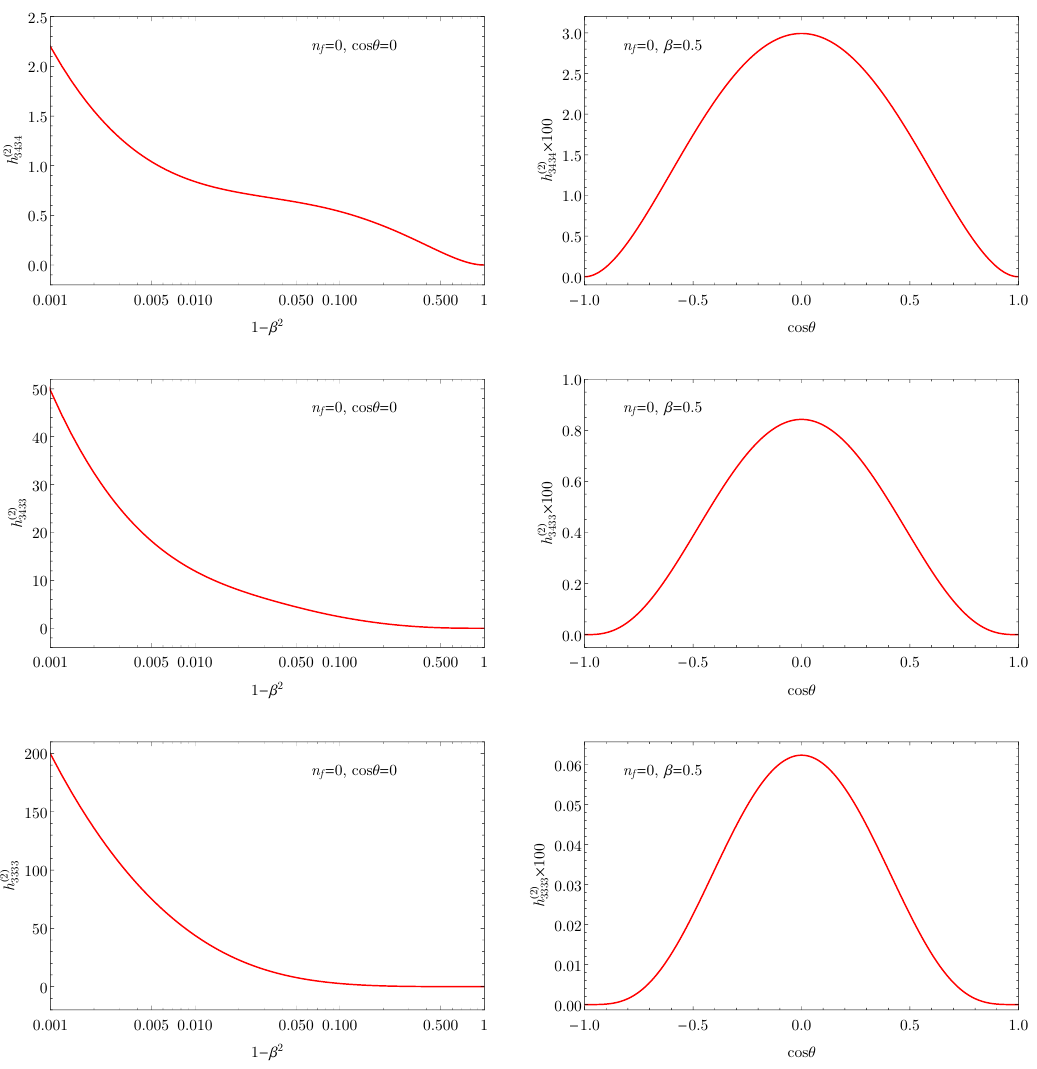
Figure 3 . Same as in figure 2 for the contributions proportional to T 3 · T 4 T 3 · T 4 (upper panels), (lower C F T 3 · T 4 (middle panels) and C 2 F